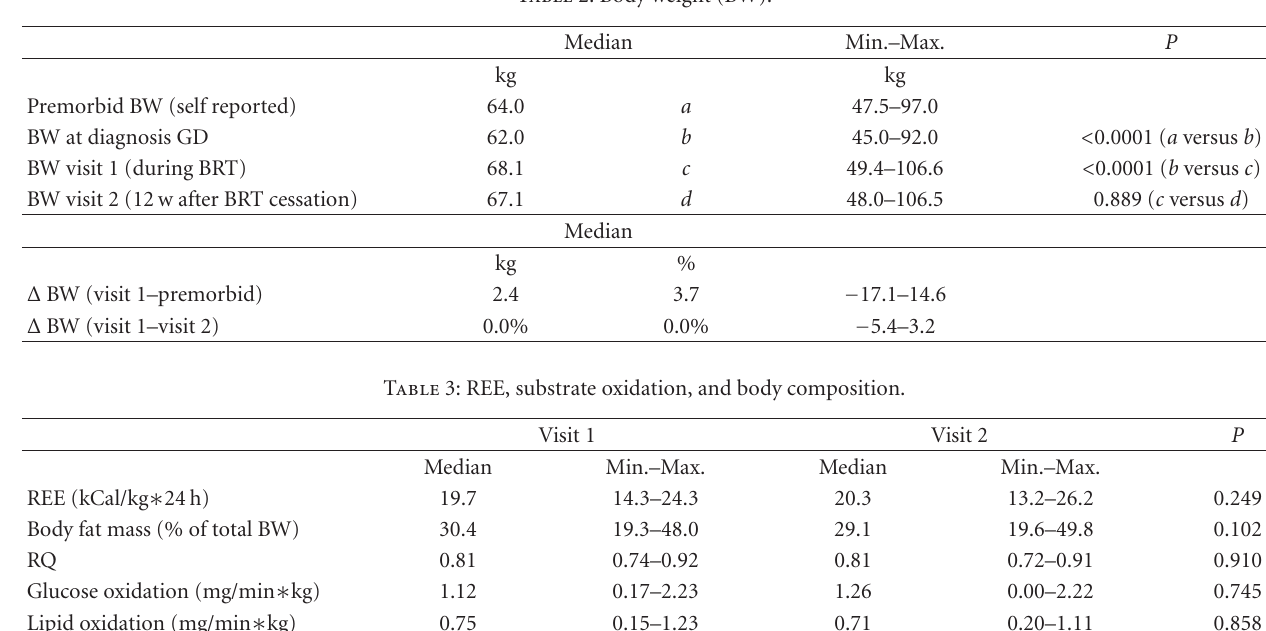
Table 2: Body weight (BW).